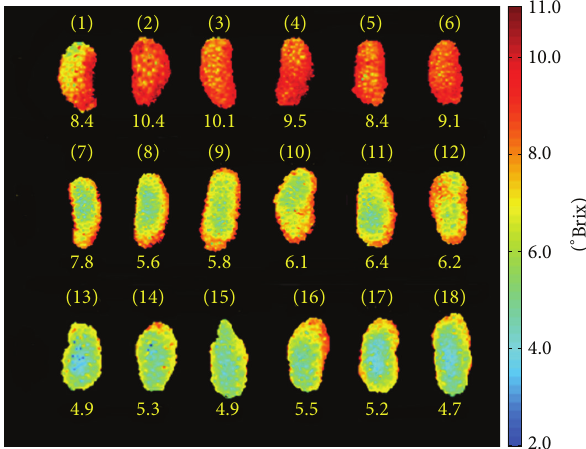
Figure 8: TSS visualization of mulberry